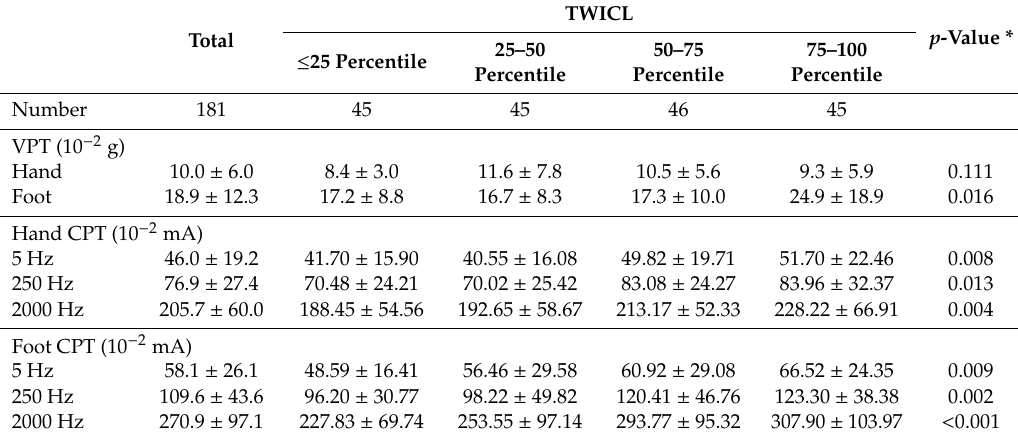
Table 2. Neurological outcome examinations of the lead